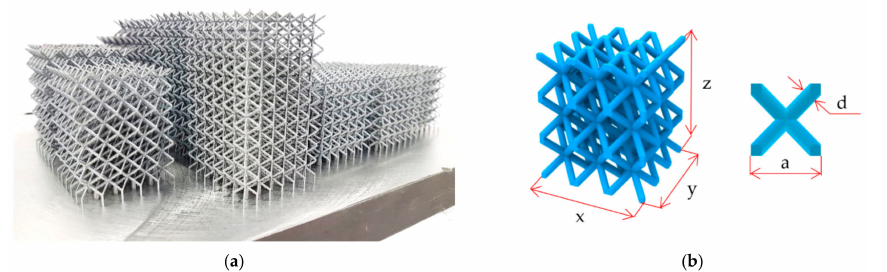
Figure 1. ( a ) The batch of SLM produced lattice structures cubes from AlSi10Mg. ( b ) Geometrical parameters of the lattice structures and a unit cell of BCC